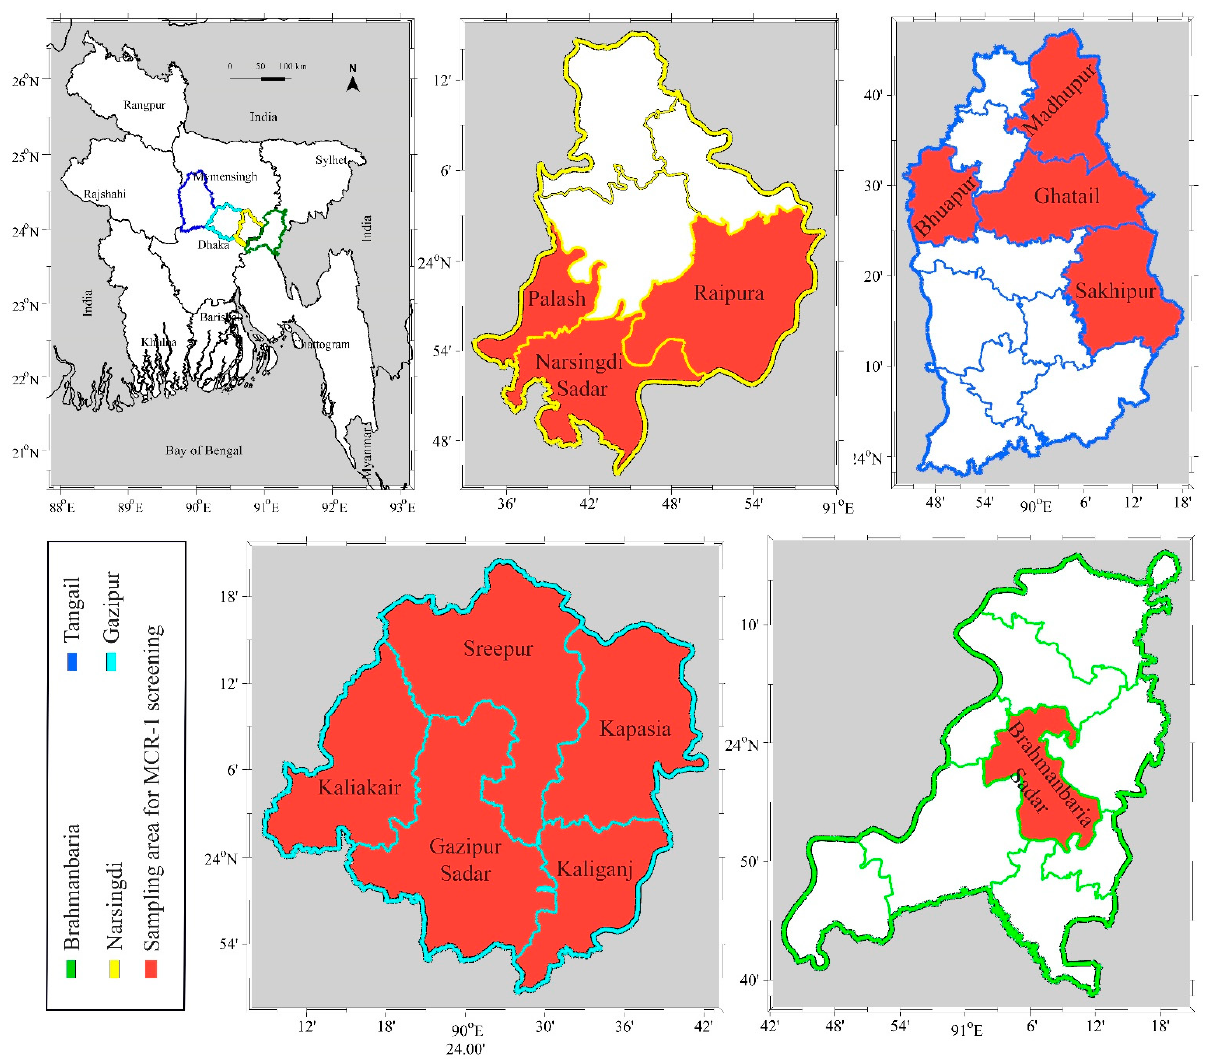
Figure 1. Geographical map of Bangladesh showing the locations of the sampling areas in selected districts in the present study. Areas where the colistin resistance gene mcr-1 was screened are highlighted in red.